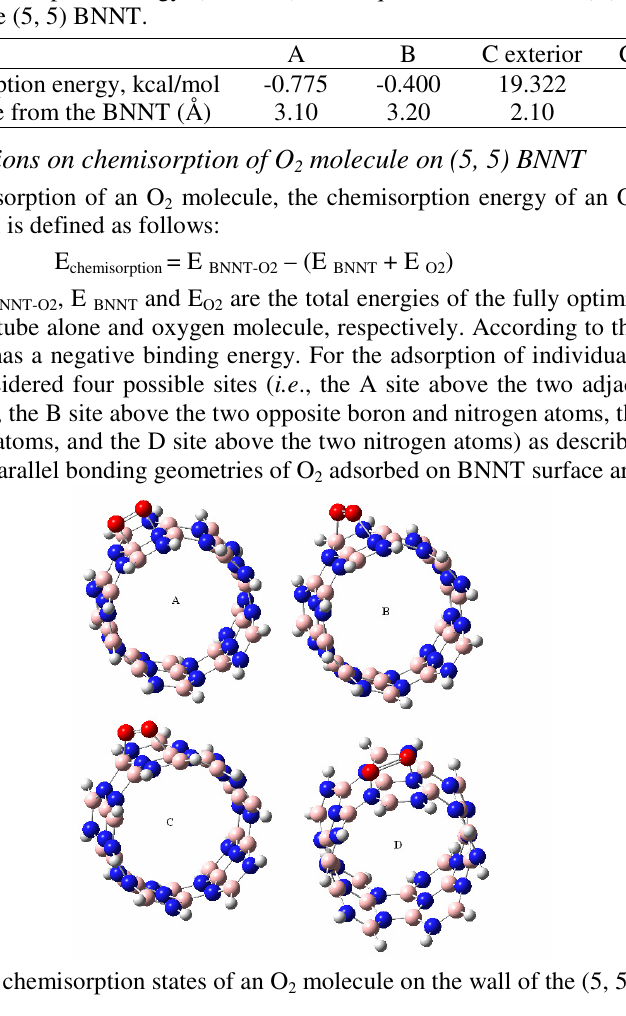
molecule on the wall of the (5, 5) 2